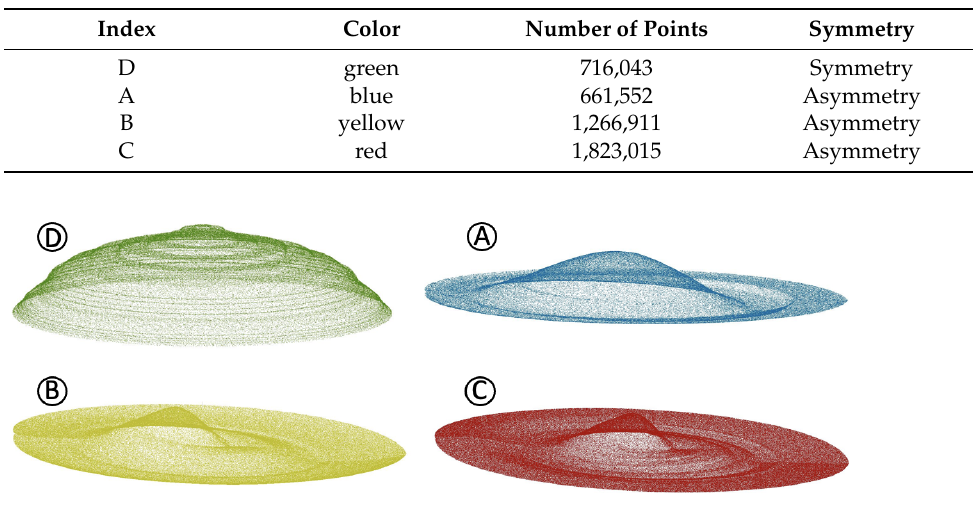
Figure 14. Reconstructed 3D points of each layer in the foundation from the corresponding 2D vertex points extracted from CAD drawing. Subfigures ( A – D ) represent the four layers shown in Figure